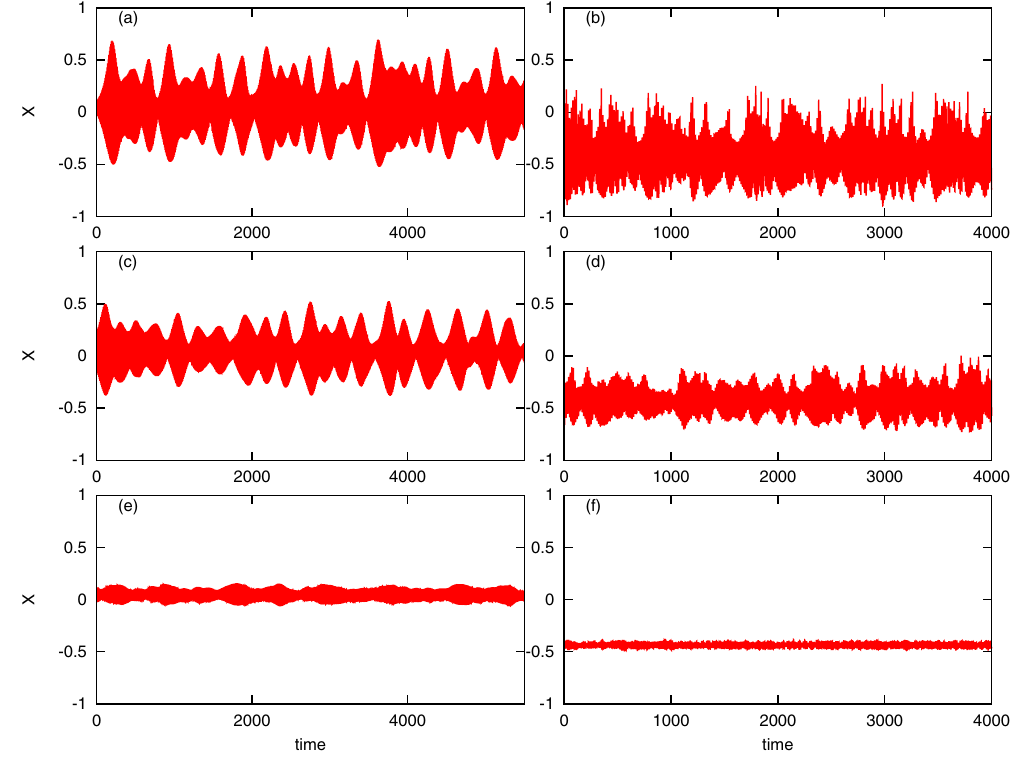
Figure 5. Dynamical regimes for different diversities of parameters. Panels (a,c,e): I = 0.008, panels (b,d,f): I = 0.012. Values of the parameter Δ H k : panels (a,b): Δ H k = 0.01; panels (c,d): Δ H k = 0.02; panels (e,f): Δ H = 0.04. For the regimes without diversity see panels (c,d,e,f) in Fig. 3 k